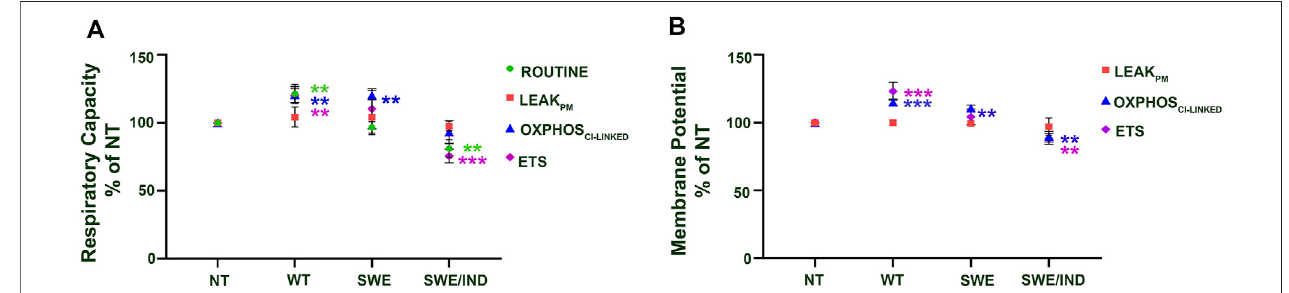
FIGURE 2 | Comparison between SH-SY5Y cells overexpressing different types of APP (WT, Swe and Swe/Ind) at different mitochondrial bioenergetic states (ROUTINE, LEAK PM , OXPHOS CI-LINKED and ETS) expressed as % of nontransfected control (NT). (A) Respiratory capacity and (B) membrane potential. **: p < 0.01, ***: p < 0.001. Data are expressed as the mean ± SD, (N (cid:1)